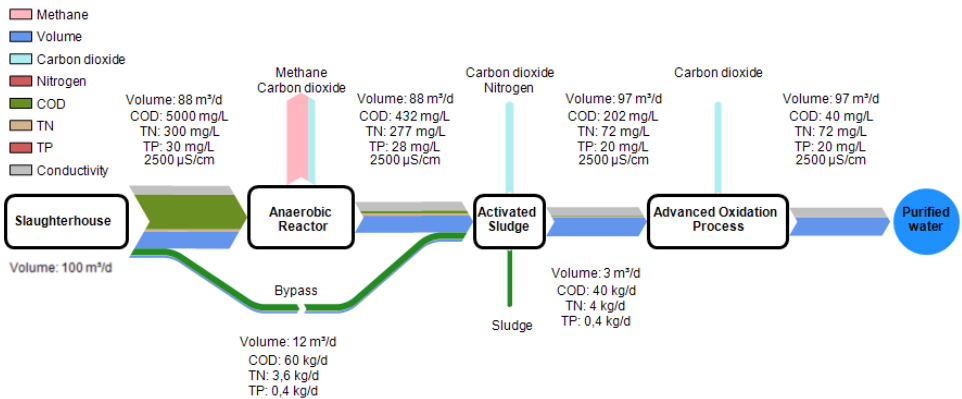
Figure 11. Sankey diagram and flow scheme for option